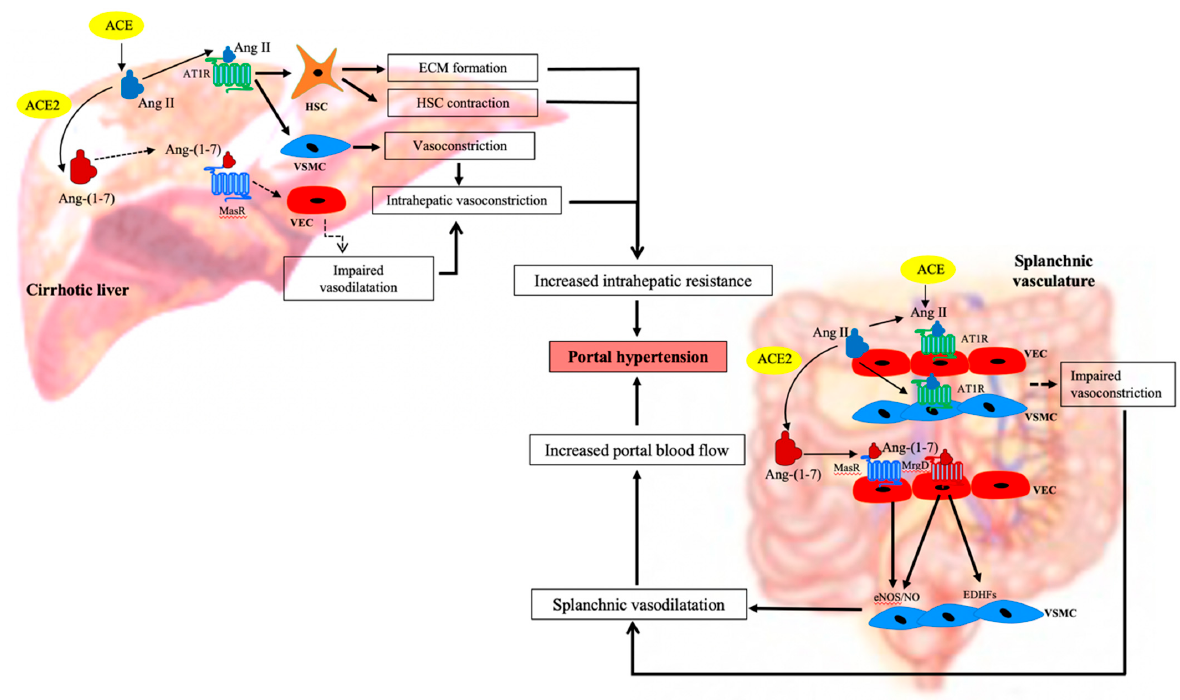
Figure 4. Role of the renin angiotensin system in cirrhotic portal hypertension. Development of portal hypertension in cirrhosis is a combined effect of the changes that occur within the intrahepatic and splanchnic vascular beds. In the cirrhotic liver, vasoconstrictor peptide angiotensin II (Ang II) signals through its receptor Ang II type 1 receptor (AT1R) in activated hepatic stellate cells (HSCs) to increase the extracellular matrix proteins (ECM) deposition, creating a fixed barrier to the incoming portal blood flow which raises portal pressure. In addition, Ang II also promotes the contraction of the activated HSCs and vascular smooth muscle cells (VSMCs), further increasing intrahepatic vascular tone, exacerbating portal pressure. Increased intrahepatic resistance is further augmented by the reduced release of vasodilatory molecules such as nitric oxide (NO) from vascular/sinusoidal endothelial cells (VECs) in the cirrhotic livers. In addition, the intrahepatic vasodilatory function of angiotensin-(1–7) (Ang-(1–7)) peptide produced from Ang II by ACE2 action is also diminished, further contributing to intrahepatic resistance. In contrast, in the cirrhotic splanchnic vascular bed, circulating Ang-(1–7) increases the release of NO via its putative receptor Mas (MasR) and possibly other factors such as endothelium-derived hyperpolarizing factors (EDHFs) via the Mas related G protein-coupled receptor type-D (MrgD) from VECs. This promotes the relaxation of VSMCs which leads to dilatation of the splanchnic vascular bed leading to an increased portal blood flow. This further aggravates portal pressure. Splanchnic vasodilatation is also aggravated by intrinsic splanchnic vascular hypocontractility to vasoconstrictors such as Ang II. ACE, angiotensin converting enzyme; ACE2, angiotensin converting enzyme 2; eNOS, endothelial nitric oxide synthase. Adapted from